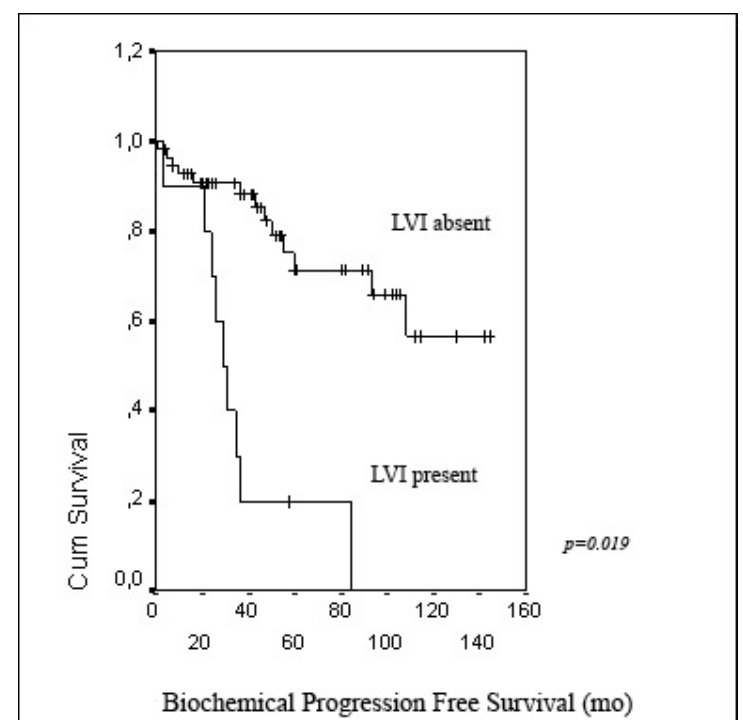
FIGURE 4. Biochemical PFS curves of the patients in regard to